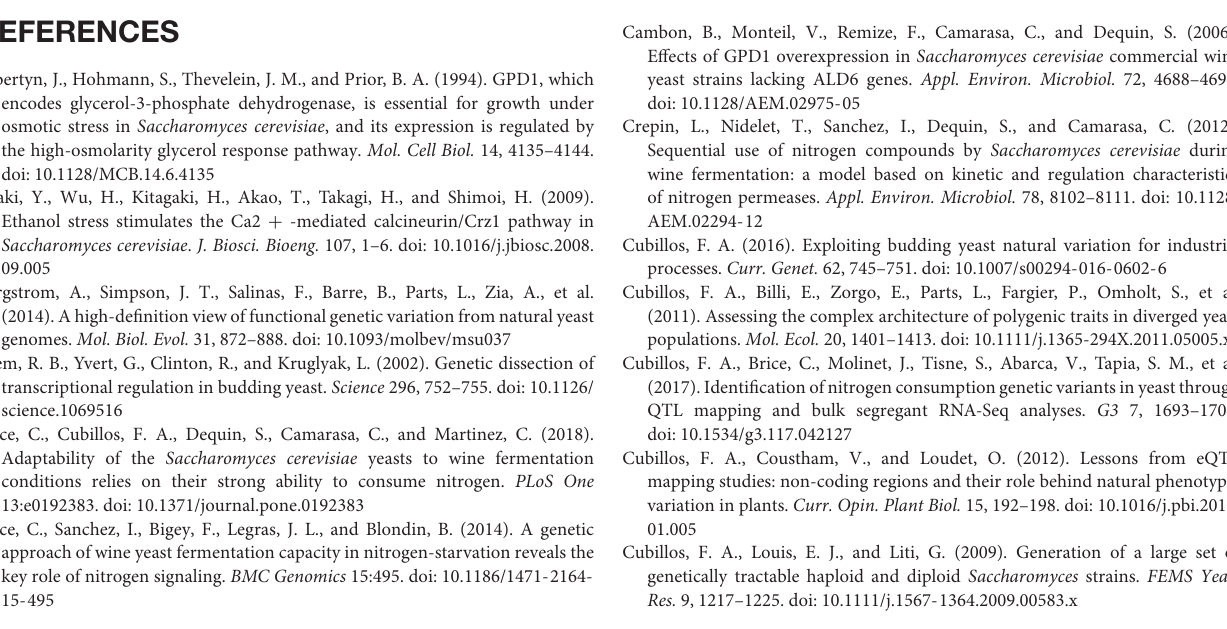
FIGURE S1 | GPD1 gene expression profiles in (A) parental SWM, (B) parental YNB, and (C) allele swapped strains in SWM. Raw luminescence and OD values